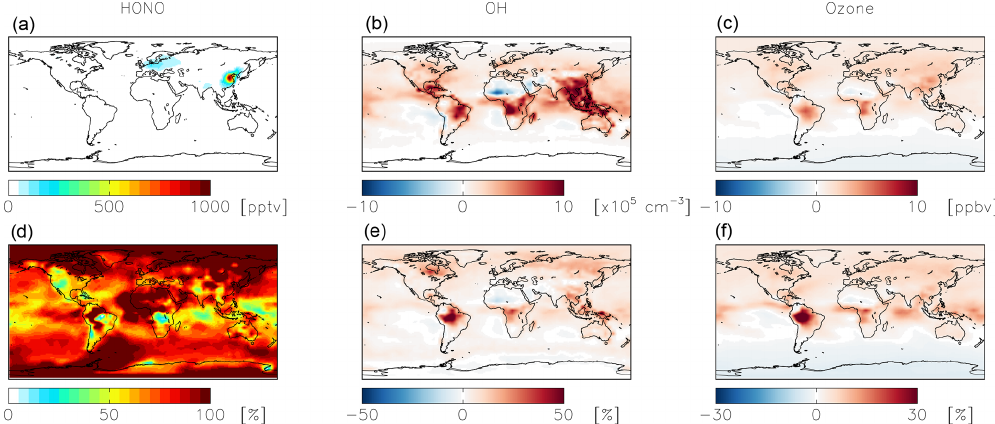
Figure 9. Absolute (a, b, c) and relative (d, e, f) change in HONO (a, d) , OH (b, e) , and ozone (c, f) concentrations below 1km altitude between the standard model and the model simulation with an acidity-dependent yield from NO 2 hydrolysis. Positive numbers represent an increase relative to the standard